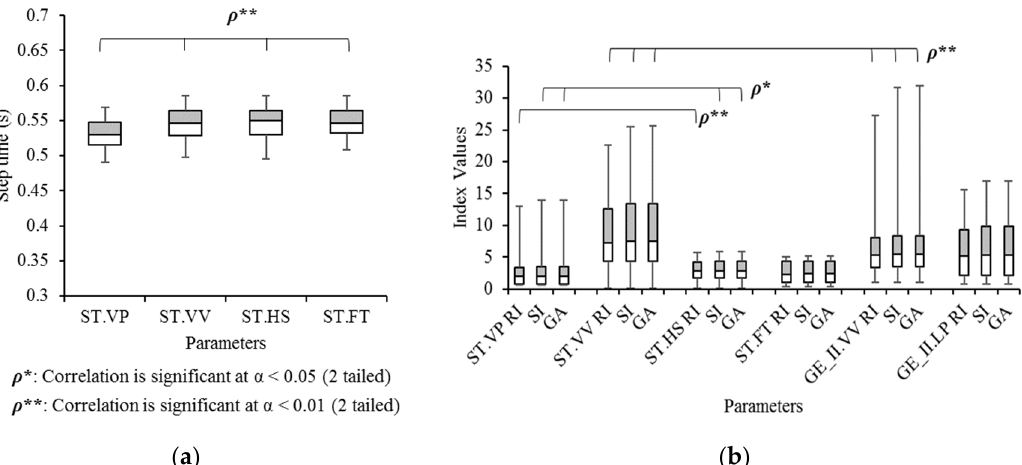
Figure 10. Box and Whisker diagrams of ( a ) the step time in four different measurement sources and ( b ) and their three gait symmetry indices.